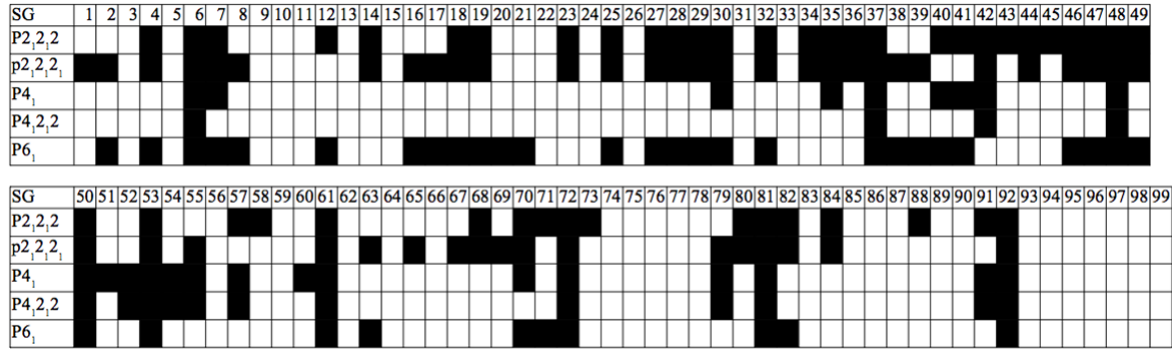
Figure 5. PR B -factor (orange) and spatial displacement (blue) variation with residue